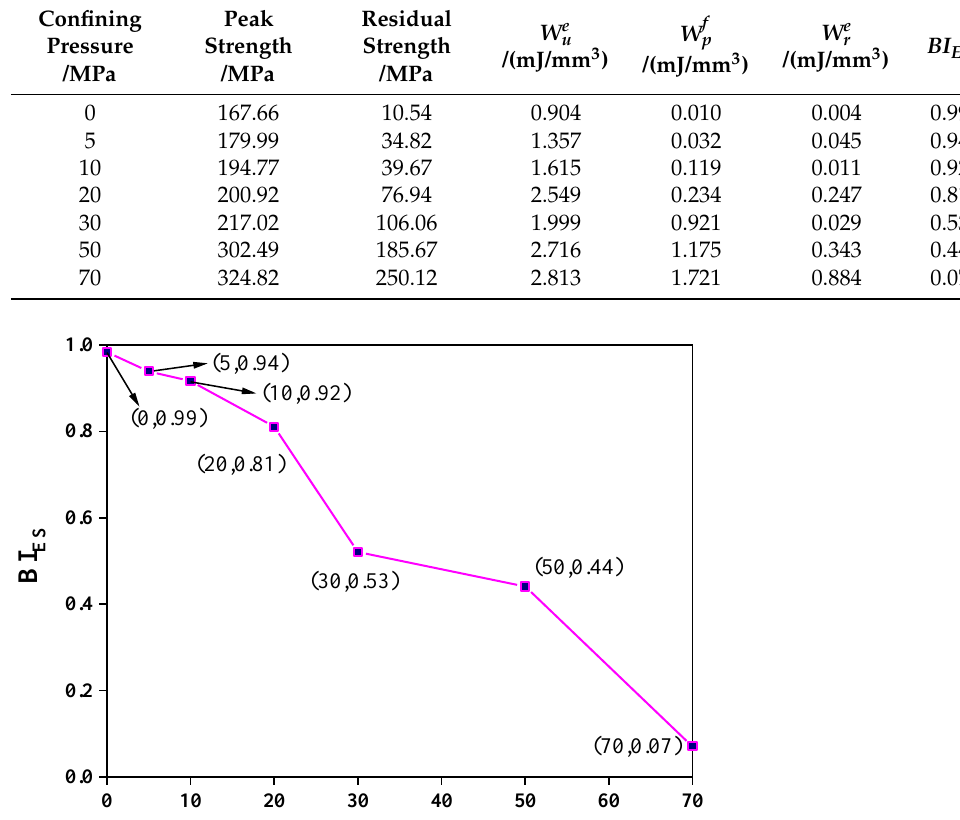
Table 5. Calculated brittleness index, BI ES , of the shale samples in the CTC tests.